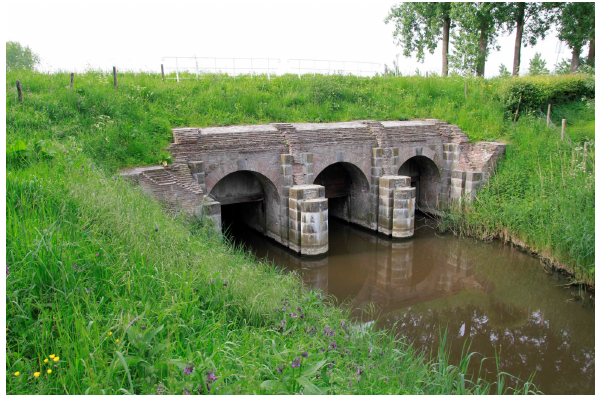
Figure 5. Land side of an inundation sluice, built in 1789 by the Estates General of the Dutch Republic at Zwartenhoek (51 ◦ 15 (cid:48) N and 3 ◦ 51 (cid:48) E). Notice the double groove in the protruding parts in which beams could be installed. As the space in between the beams could be filled with earth, this construction was strong enough to prevent the fresh water from flowing seaward. After some weeks water in polders could reach a level of some decimetres. As soon as the threat of war disappeared, beams and earth were removed again (photo: Nellie de Kraker).